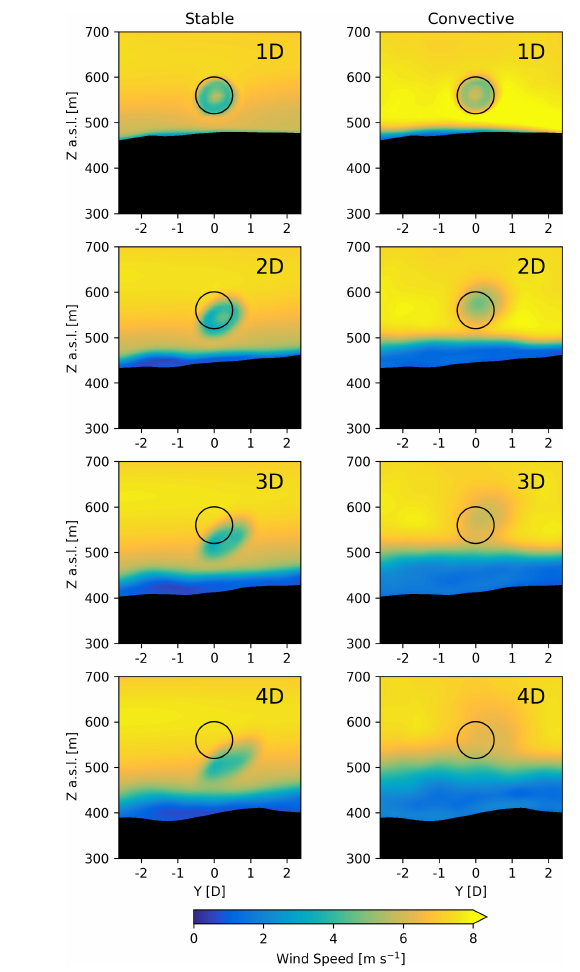
Figure 13. One-hour time-averaged wind speed at different down- stream distances for the stable and convective case studies taken along the wake transect in Fig. 1. The black circle represents the circumference of the wind turbine rotor at a constant height above sea level (a . s . l .